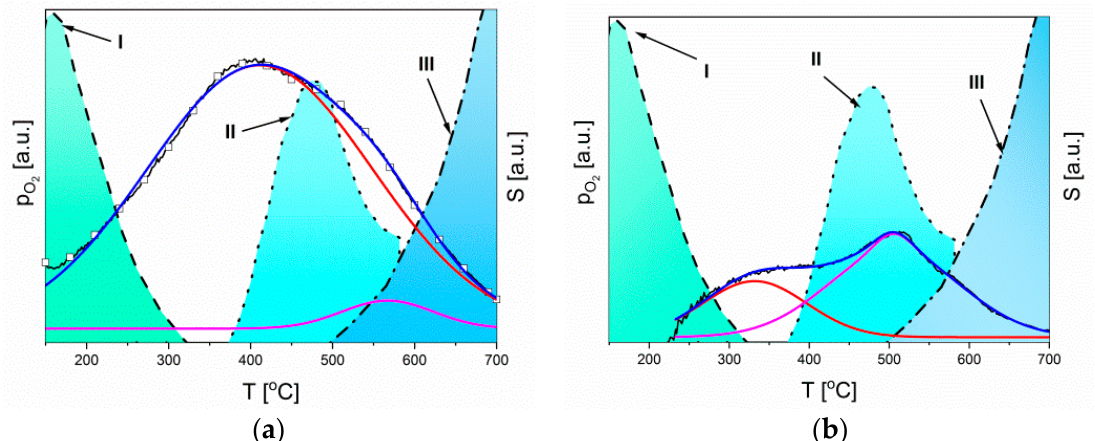
Figure 11. Changes of oxygen partial pressure on the ZnO surface [64] and sensitivity in an atmosphere containing chlorine: ( a ) layer of ZnO microrods, ( b ) layer made by screen printing. I—oxygen chemisorption combined with charge exchange with ZnO. II—desorption of chemisorbed oxygen bound to the ZnO surface. III—sublimation of highly defective zinc oxide.